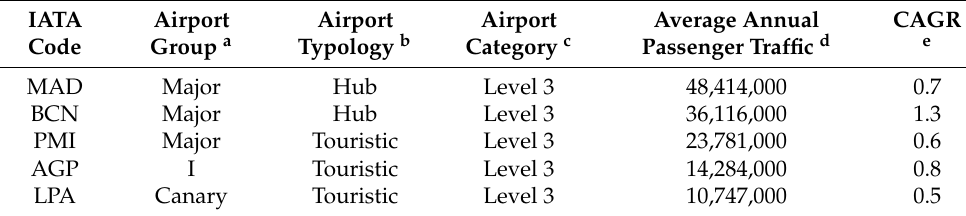
Figure 3. Overview graphic of the routes analyzed in the study whose pollutant emissions have resulted in estimated tons of carbon dioxide equivalent greater than 1.5% with regard to the five airports. Source: own calculations based on data provided from primary sources ([19,20]). Note: the use of color-coded airports, in addition to their IATA designators, has been harmonized throughout the paper, depending on each of them, for a better understanding. Table 1. Key facts of air passenger traffic at main airports in Spain between 2004 and Table 2. Existing civil air facilities in Spain (as of 14 November 2022).